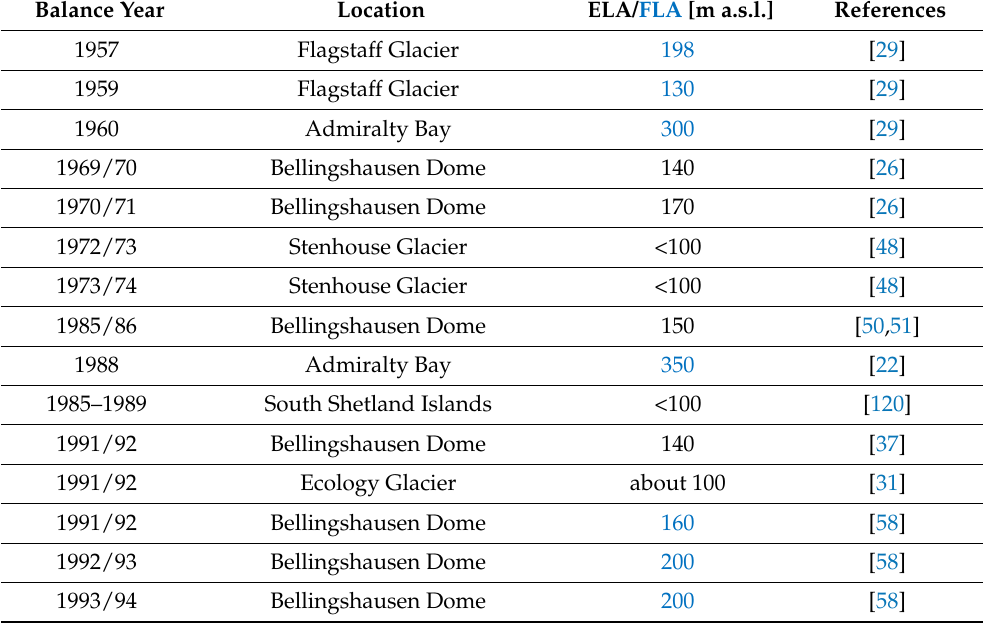
Table A2. The collated results of ELA and FLA fluctuation observations collected on KGI glaciers. * winter